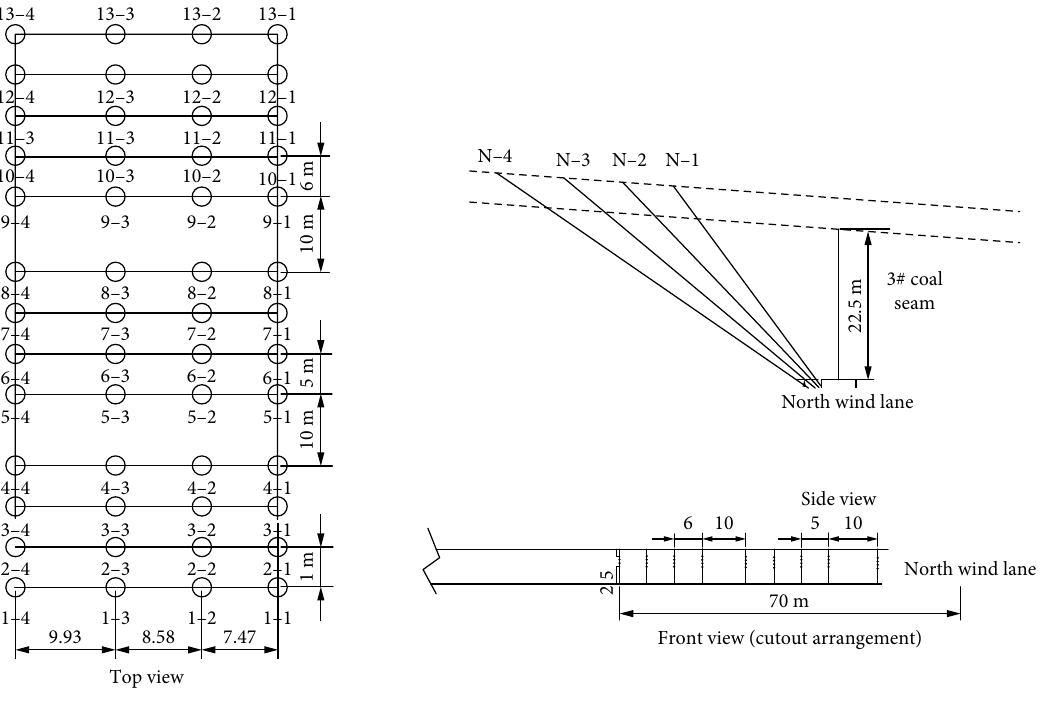
Figure 20: Drilling plan.